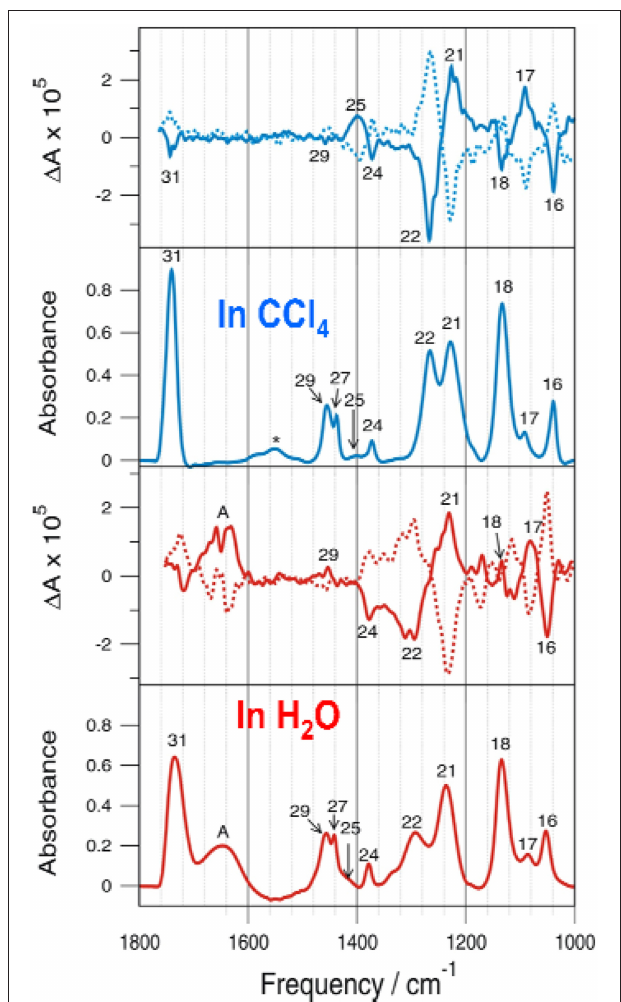
FIGURE 7 | Comparison of the experimental IR and VCD spectra obtained for S -ML in CCl 4 and in water. For the VCD section, the spectra of R -ML are shown in dotted line. Reprinted with permission from Losada and Xu (2007). Copyright 2007, The Royal Society of Chemistry.